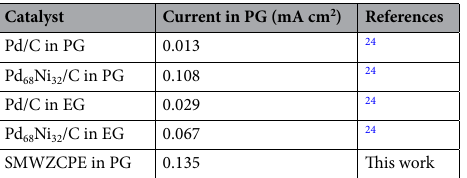
Table 3. The comparison of current density for the electrochemical oxidation of alcohol a . [a] PG is propylene glycol, EG is ethylene